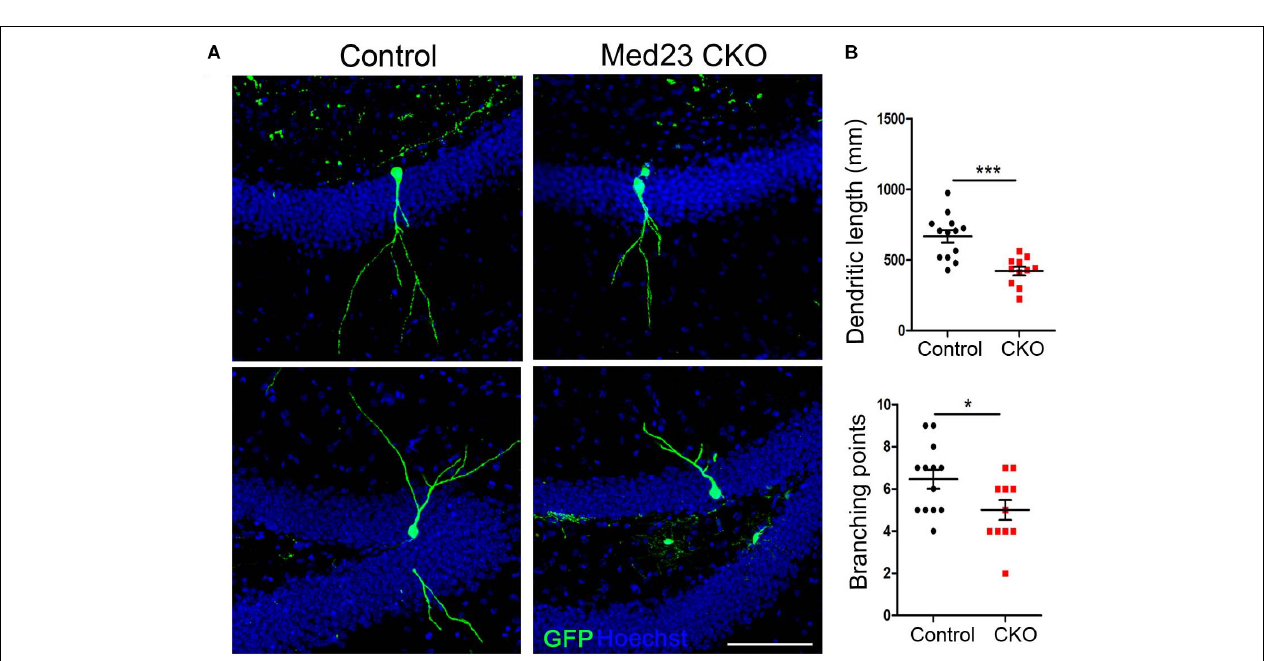
FIGURE 5 | Mature new-born neurons is also reduced in Med23 CKO mice. (A) Schematic representation of TAM treatment and BrdU injection protocol for the examination of newborn neuron survival. (B) Double immunostaining of BrdU (green) and NeuN (red). Arrows point to BrdU/NeuN-double positive cells and triangles point to cells labeled with BrdU only. Scale bar = 100 µ m. (C) Quantification data show that the numbers of BrdU-single and BrdU/NeuN-double positive cells are significantly reduced in Med23 CKO mice compared with controls. N = 5 in each group. Data are plotted as the mean ± SEM. Student t -test, * p < 0.05, ** p < 0.01.